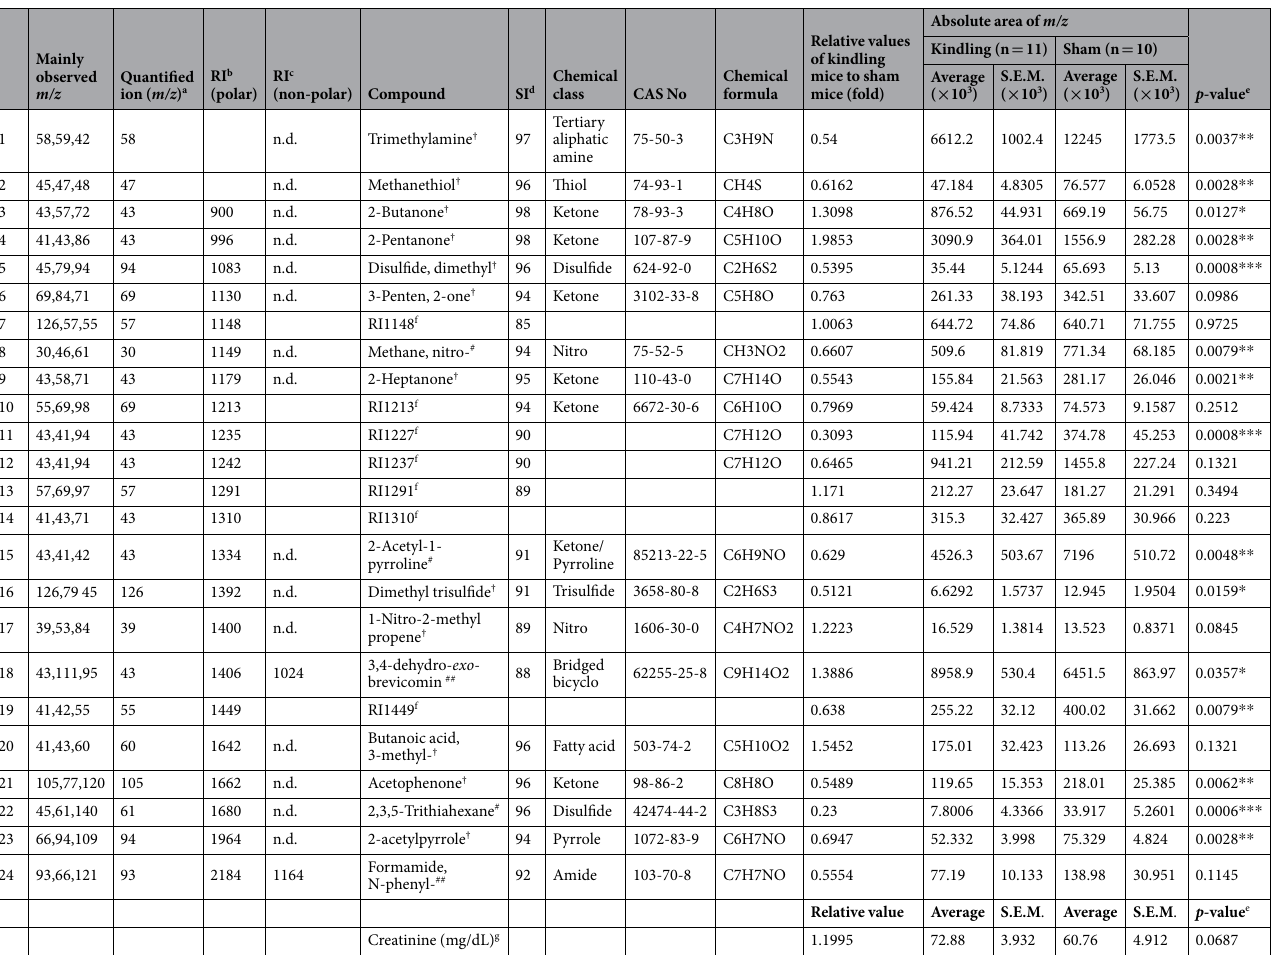
Table 1. Identification of urinary volatile organic compounds (VOCs) by XCMS, showing differential levels between full-kindled and sham-operated mice. The urine of male mice was collected daily since they acquired epileptic seizures. The NIST 14 standard reference database 60 tentatively identified VOCs from peaks of total ion current (TIC) chromatogram as described in Table S1. VOCs in amygdala-stimulated kindled and sham- operated mice were analyzed with XCMS, resulting in 24 VOCs. Quantified ions were used to calculate the peak areas of the VOCs. a The area of an ion peak was used for quantification of urinary VOCs. b Retention indices of VOCs by the InertCap PureWAX column. c Retention indices of VOCs by the DB-1 column (n.d., “not detected”). d The similarity indices (SI) show the similarity with the mass spectrum from the NIST 14 standard reference database. VOCs with SI greater than 85 were described. e Mann Whitney U -test (two-tailed). f There was no identical pattern of m/z with the authentic compounds and the retention index of the literature data exhibited in the NIST library, while the maximum similarity index with the MS spectrum was above 85%. g Urinary creatinine concentrations were determined by LabAssay TM Creatinine colorimetry kit (Wako Pure Chemical industries, Ltd. Osaka), based on the Jaffe method 59 . † VOCs were confirmed by identification with commercial standard references. #, ## Hashes indicate that the retention index of the VOCs calculated with retention time in the polar (InertCap PureWAX) # and non-polar (DB-1) ## columns were identical with the literature data,